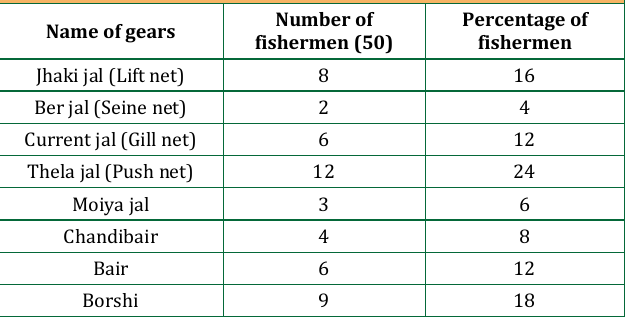
Table 1: Gears and Percentage of The Fishermen Who Used These